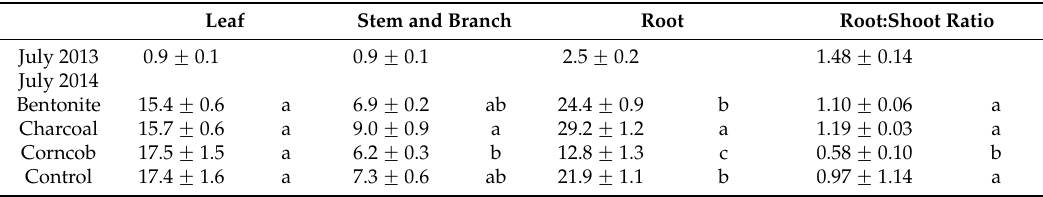
Table 2. Dry mass of each organ (leaf, stem and branch, and root) and root:shoot ratio for teak seedlings before transplantation (Mean ± SE, n = 10) and the end of the experiment (July 2014) grown with four treatments (Mean ± SE, n = 8). Different letters indicate significant differences among the four treatments calculated by Tukey’s test ( p < 0.05).